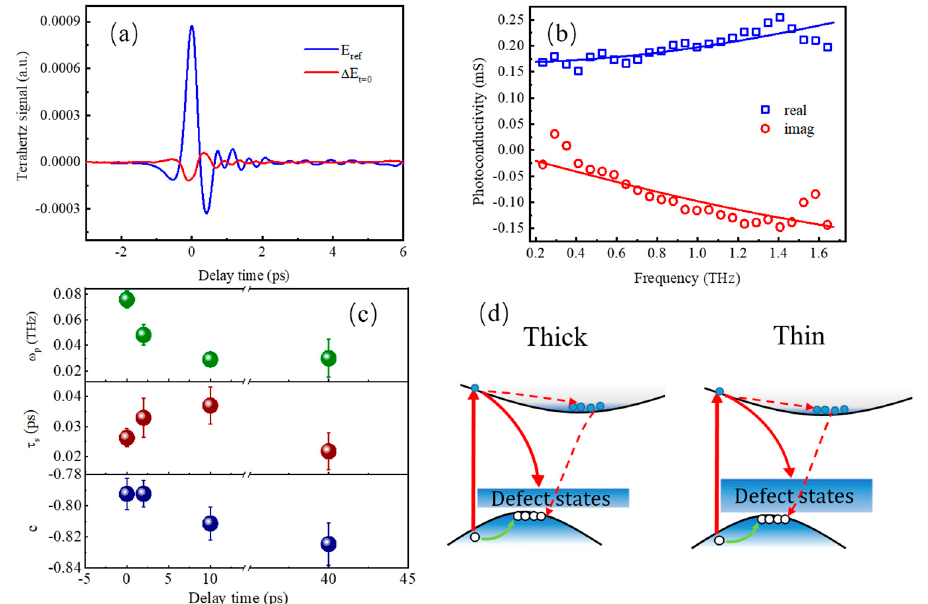
Figure 4. ( a ) THz signal of the unexcited SnS 2 film (blue) and the pump-induced transmission change at time zero (red). ( b ) The real (blue square) and imaginary (red circle) parts of PC collected at delay times of 0.5 ps, in the frequency range between 0.2–1.6 THz under a photoexcitation of 400 nm with pump fluence of 24 μ J/cm 2 . ( c ) Drude–Smith fitting parameters of the PC at respective delay times. ( d ) Schematic diagram of the carrier dynamics in SnS 2 film of different thickness.